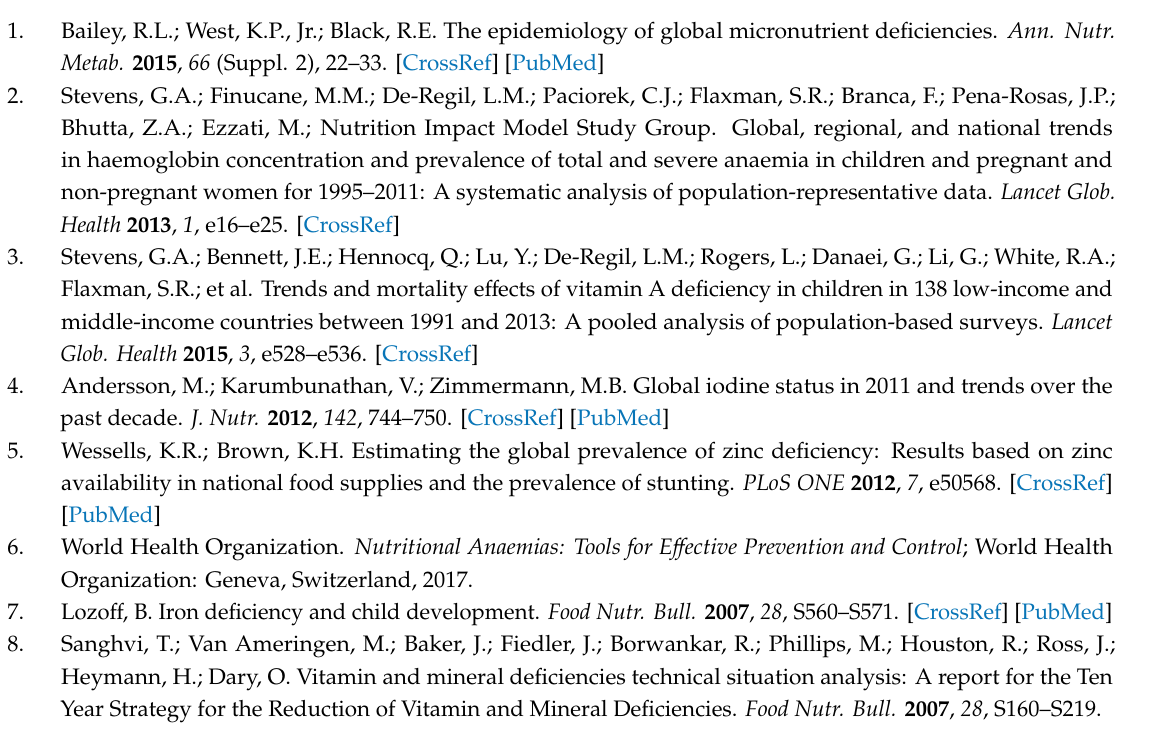
Figure S1: Additional Forest Plots, Table S1: Eligible Studies Excluded from Meta-Analyses, Table S2: Eligible Studies Included in Meta-Analyses, Text S1: MEDLINE Search